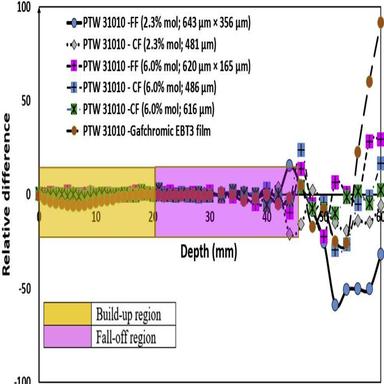
Relative difference between six dosimeter pairings: IC and 2.3% mol Ge; 643 μm × 356 μm; IC and 2.3% mol Ge; 481 μm); IC and 6.0% mol Ge; 620 μm × 165 μm; IC and 6.0% mol Ge; 486 μm); IC and 6.0% mol Ge, 616 μm and; IC and Gafchromic™ EBT3 film.